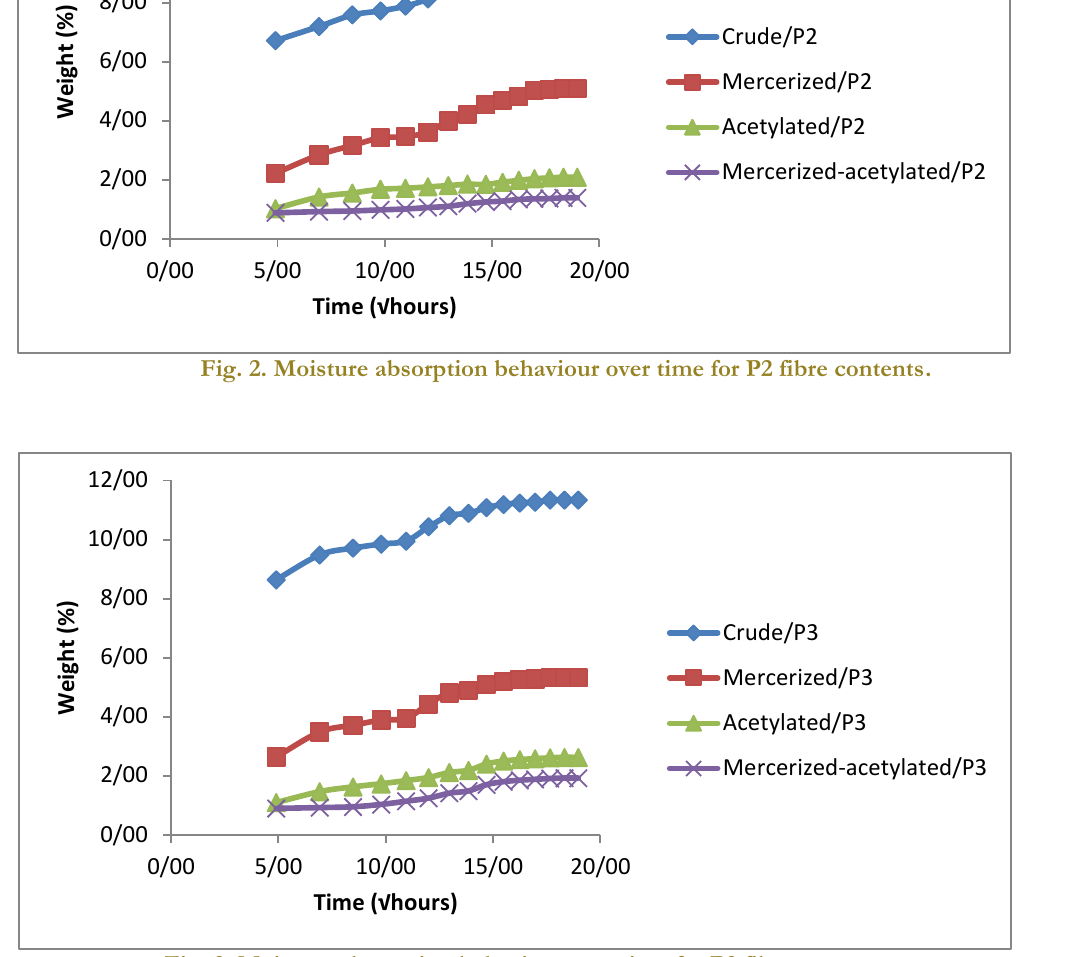
Fig. 3. Moisture absorption behaviour over time for P3 fibre contents.